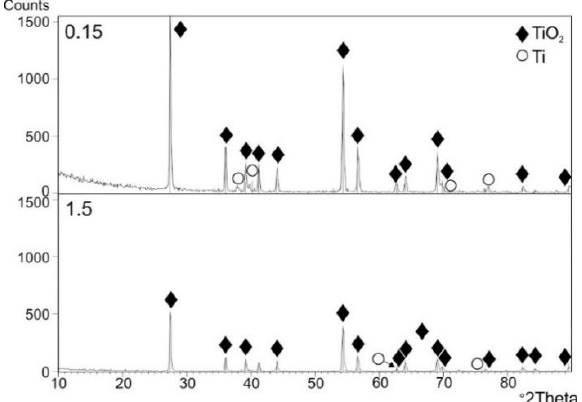
Figure 10. A set of diffraction patterns obtained by the GIXD method at beam incidence angles α = 0.15° and 1.5°, for a titanium Grade 2 specimen after cyclic oxidation (12 cycles) at 650 °C.